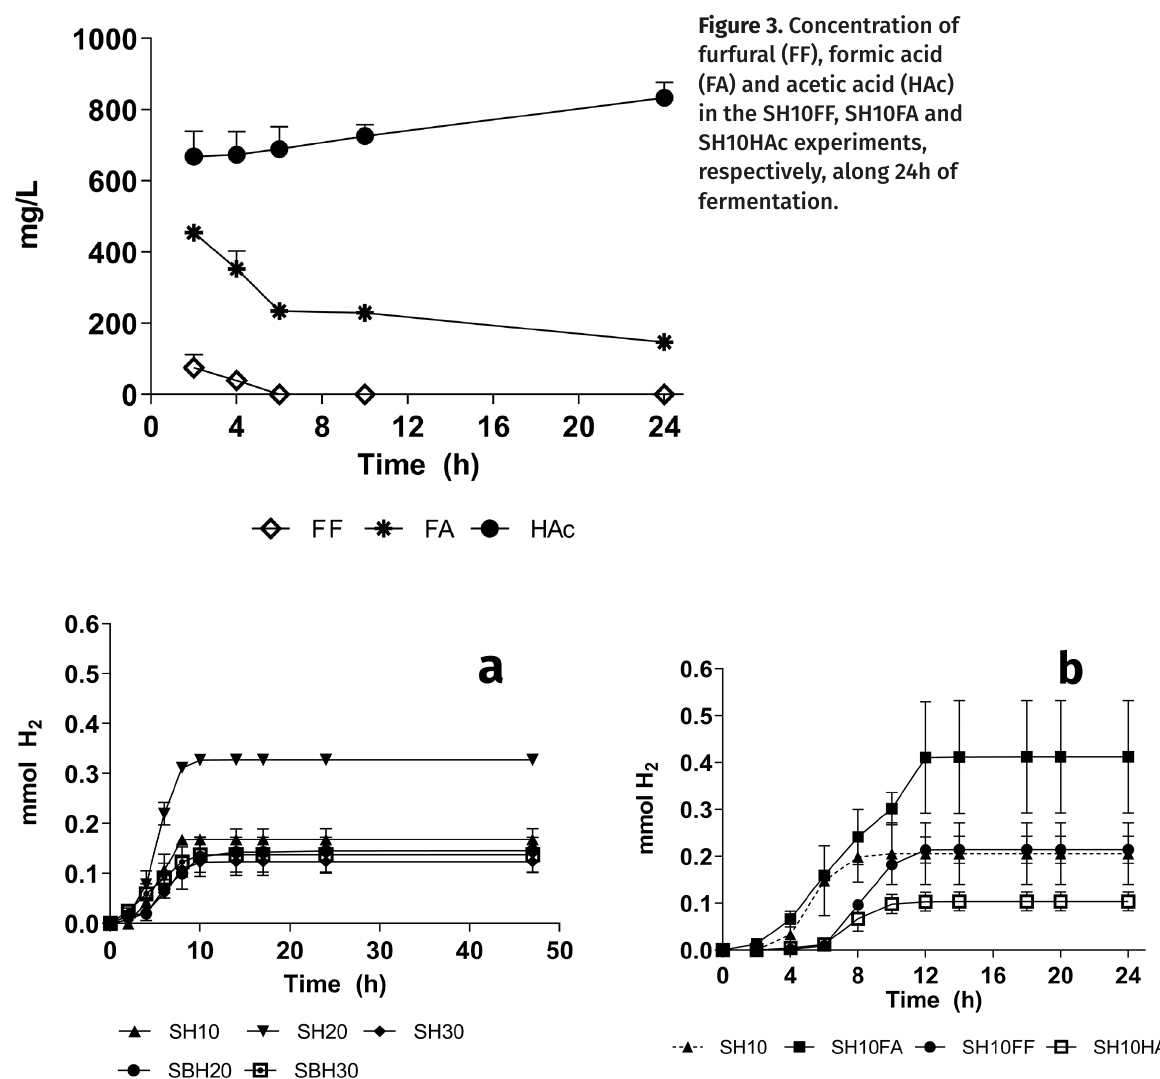
Figure 3. Concentration of furfural (FF), formic acid (FA) and acetic acid (HAc) in the SH10FF, SH10FA and SH10HAc experiments, respectively, along 24h of fermentation.